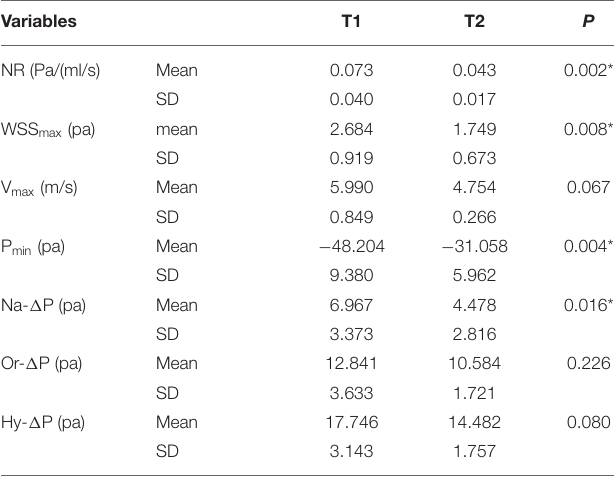
TABLE 2 | The nasal and pharyngeal aerodynamic parameters from CFD simulation.